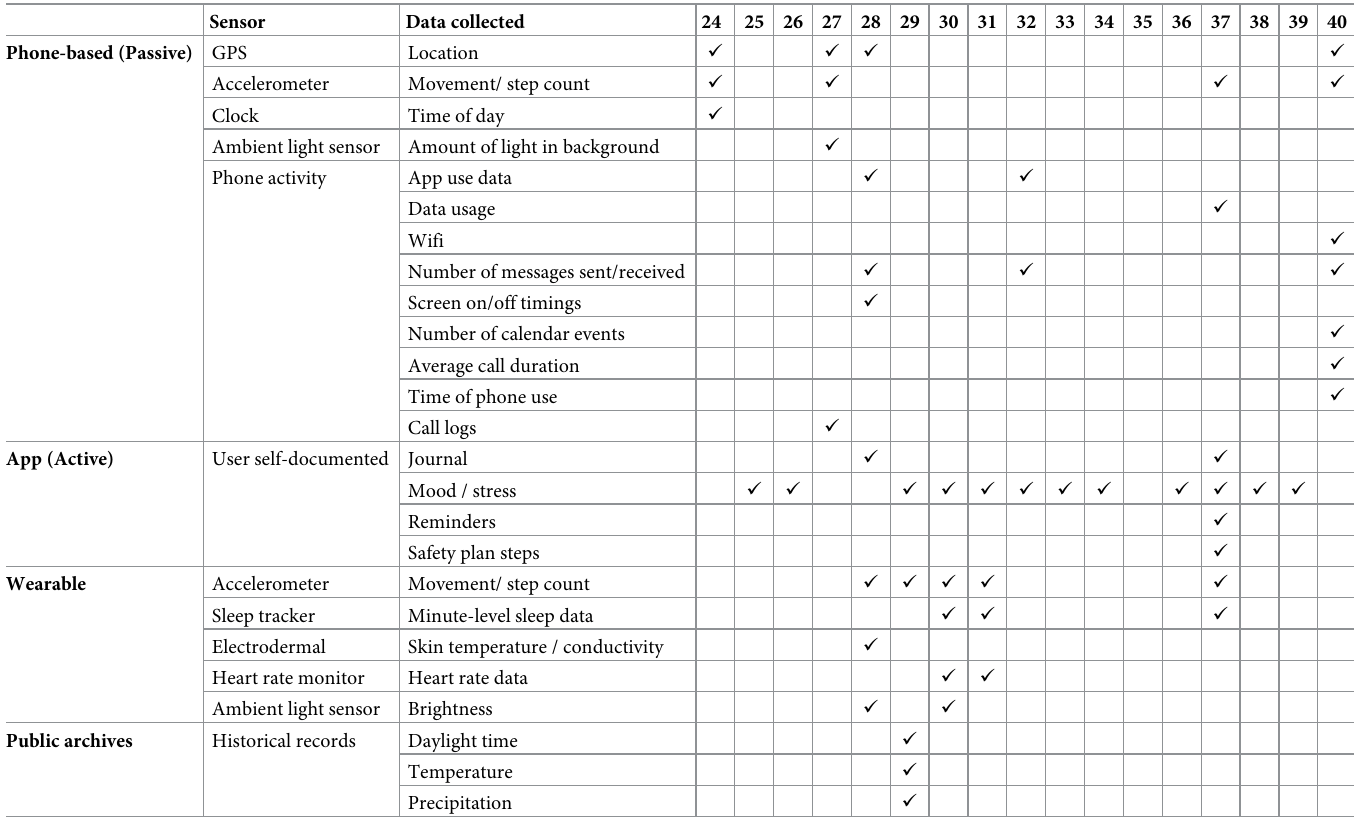
Table 4. Sensors and data collected in included studies.